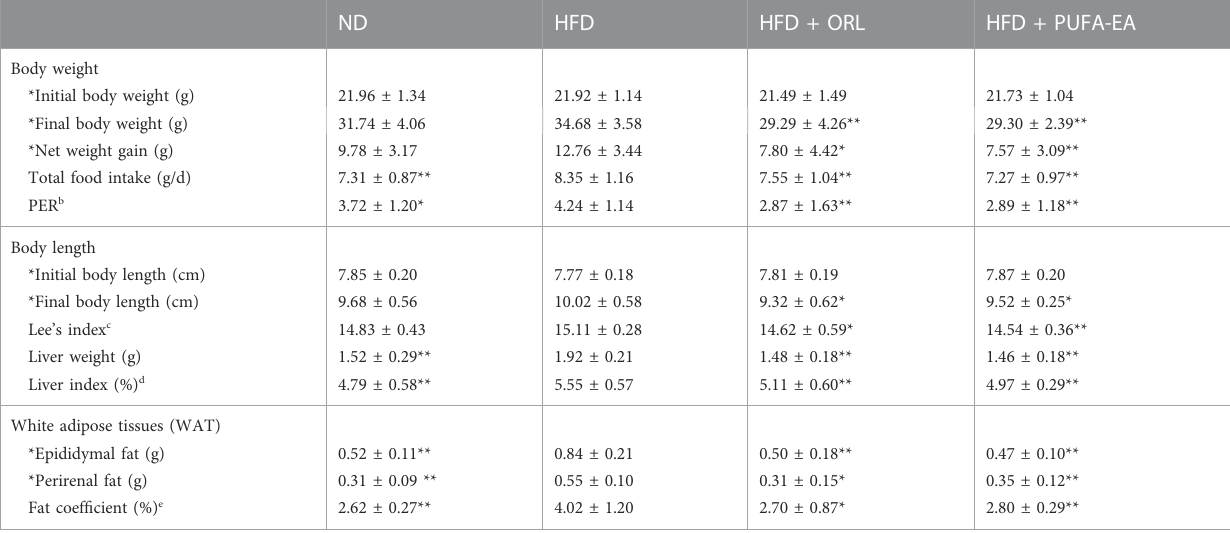
TABLE 2Theeffects of Orlistatandthe PUFA-EA mixtureonbody weightgain, foodintake,andtissue weights inHFD-fed obesemice atthe endof 6-weekfeeding (n = 10) a .